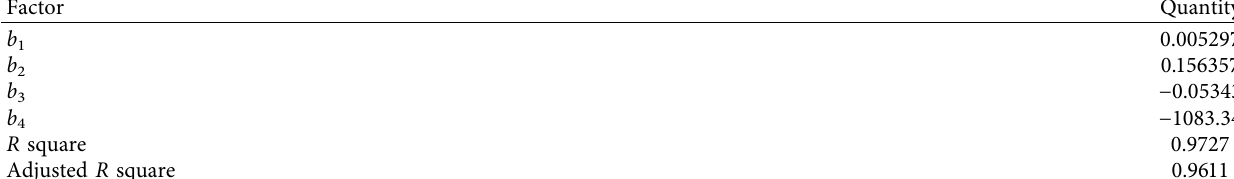
Table 2: Multivariable regression results.